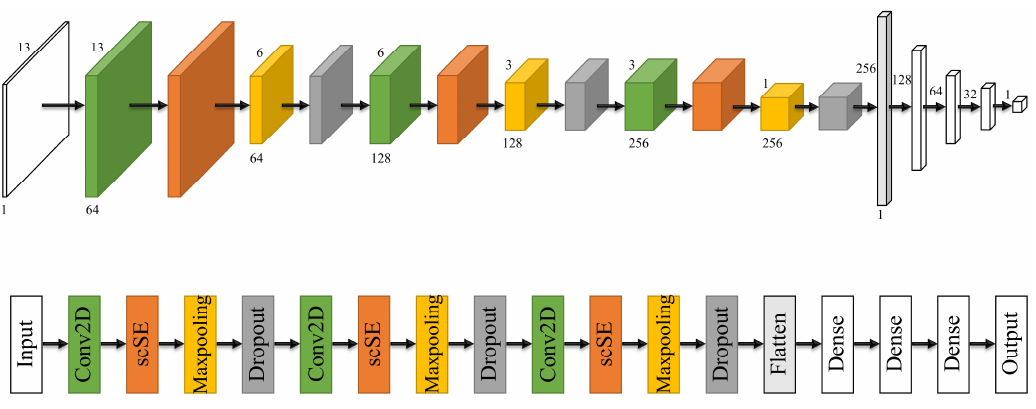
Figure 5. Overall framework of LSGH-Net.